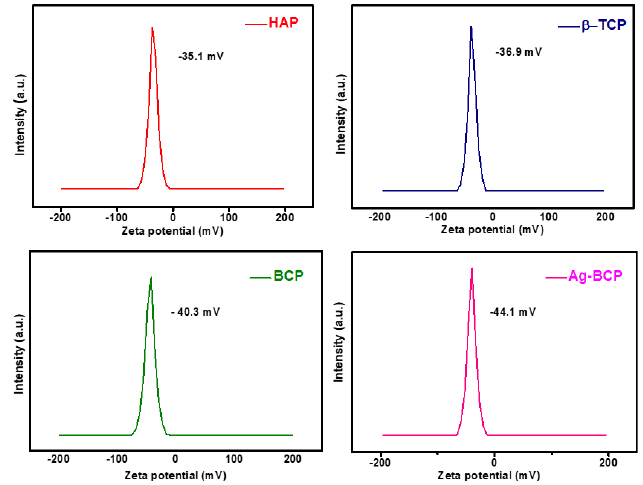
Figure 5. Zeta potential analysis of ( a ) HAP, ( b ) β -TCP, ( c ) BCP, and ( d ) Ag-BCP.